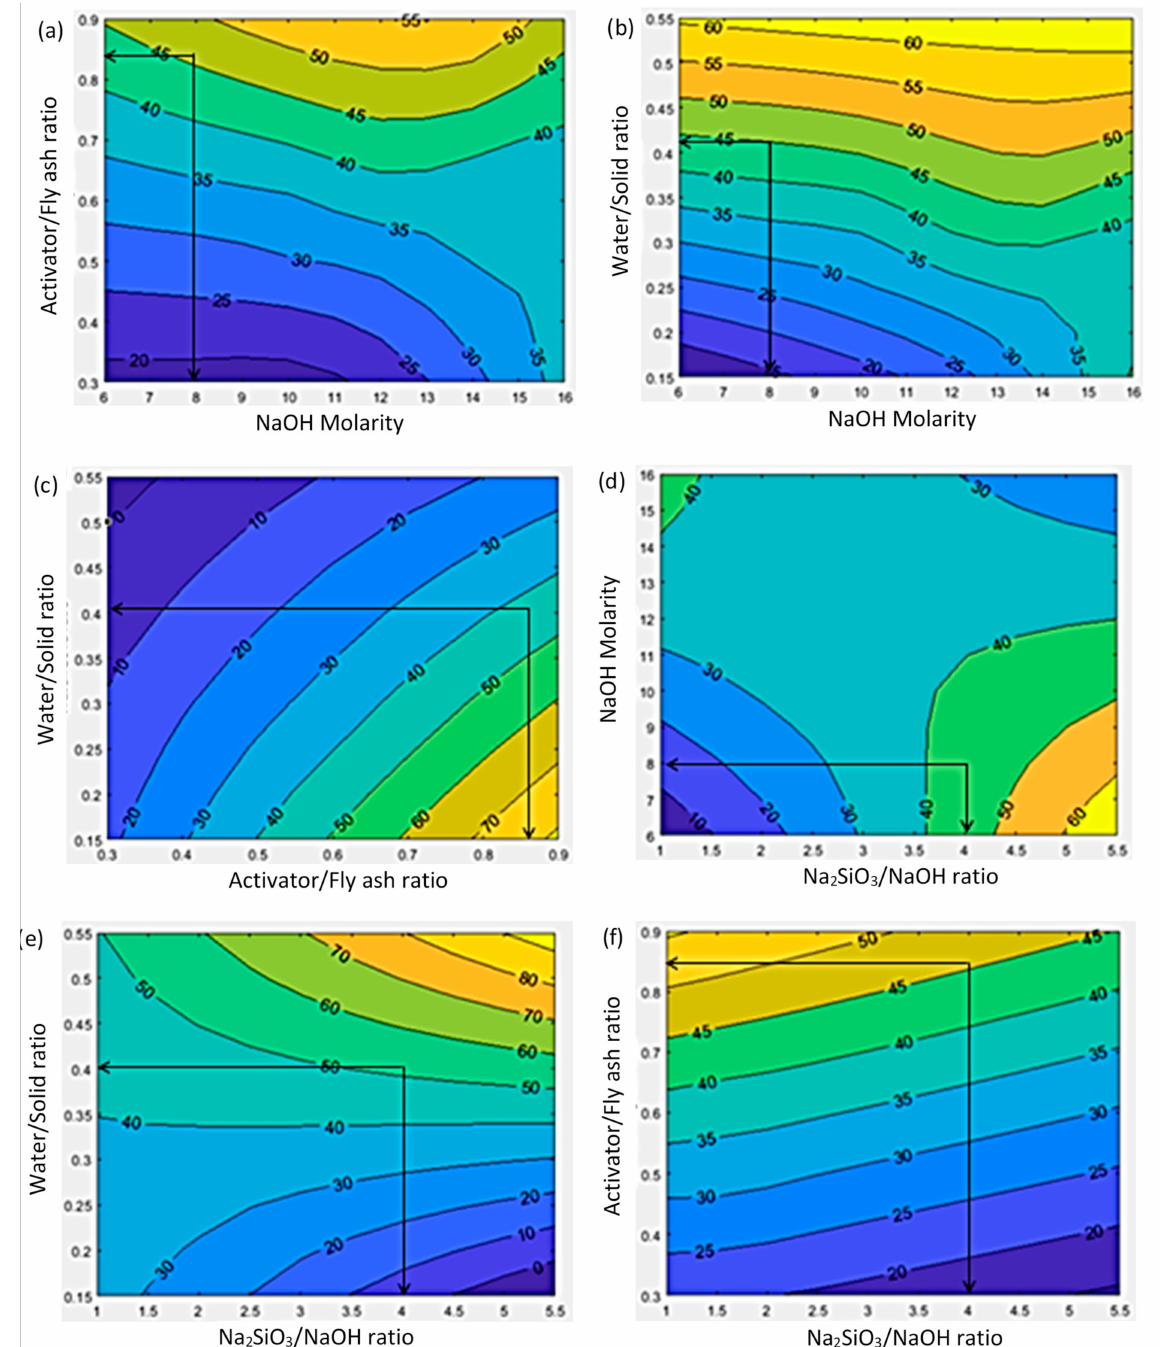
Figure 4. Effect of input parameters on the compressive strength (Note: for instance, the selected input parameters of 45 MPa mix is illustrated). Input parameters: ( a ) activator/fly ash ratio and NaOH molarity; ( b ) water/solid ratio and NaOH molarity; ( c ) water/solid ratio and activator/fly ash ratio; ( d ) NaOH molarity and Na 2 SiO 3 /NaOH ratio; ( e ) water/solid ratio and Na 2 SiO 3 /NaOH ratio; ( f ) activator/fly ash ratio and Na 2 SiO 3 /NaOH